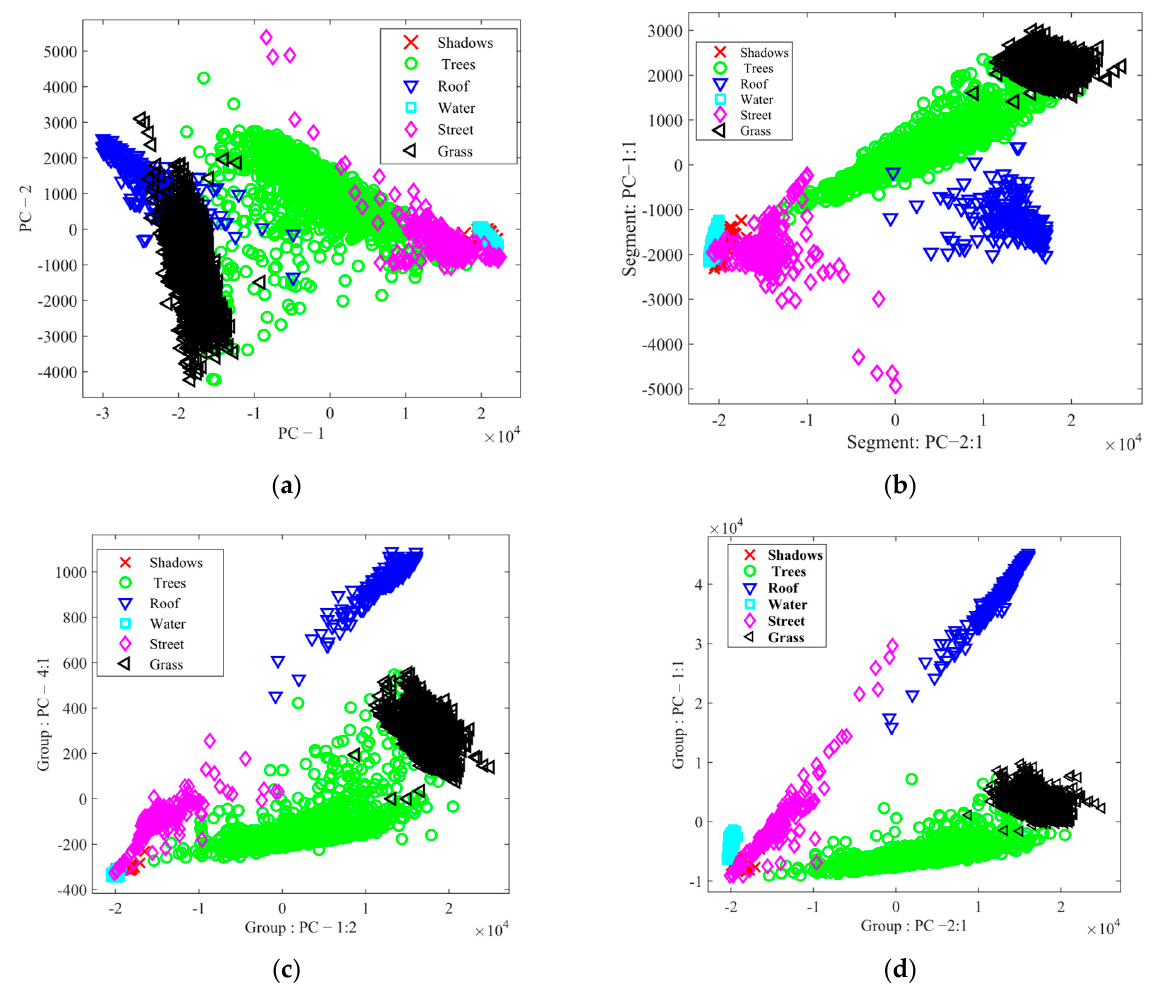
Figure 8. Scatterplots for different methods for the Washington DC Mall dataset: ( a ) PCA, ( b ) SPCA, ( c ) BgPCA, and ( d ) BgPCA-NMI.